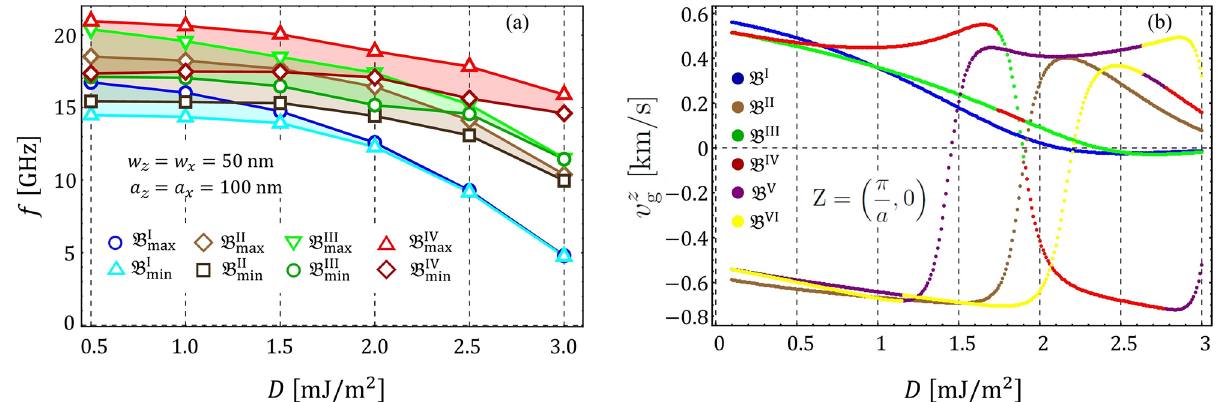
Figure 4. ( a ) Minimum and maximum values of the magnonic bands ( B n min and B n max ) as a function of the